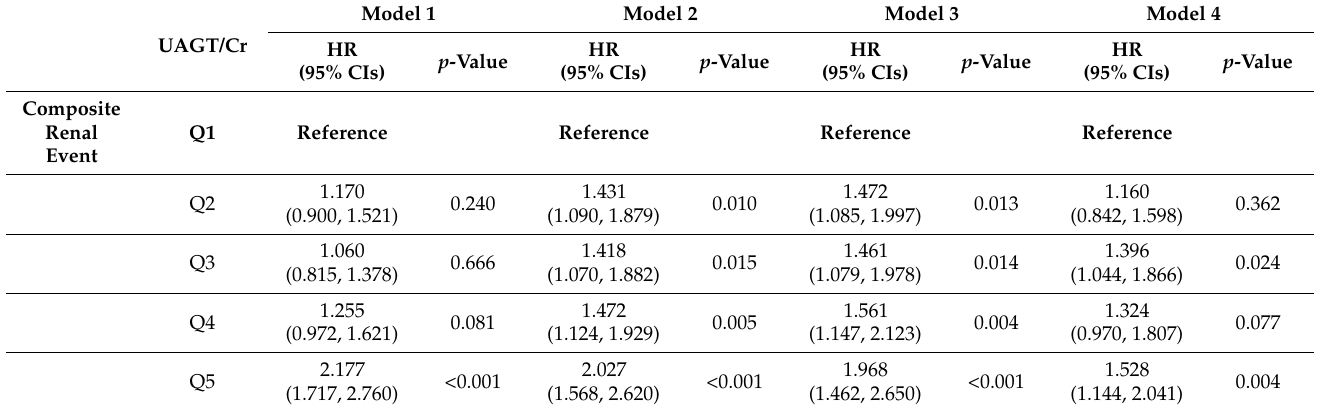
Table 3. Cause-specific HRs for composite renal event by UAGT/Cr level.